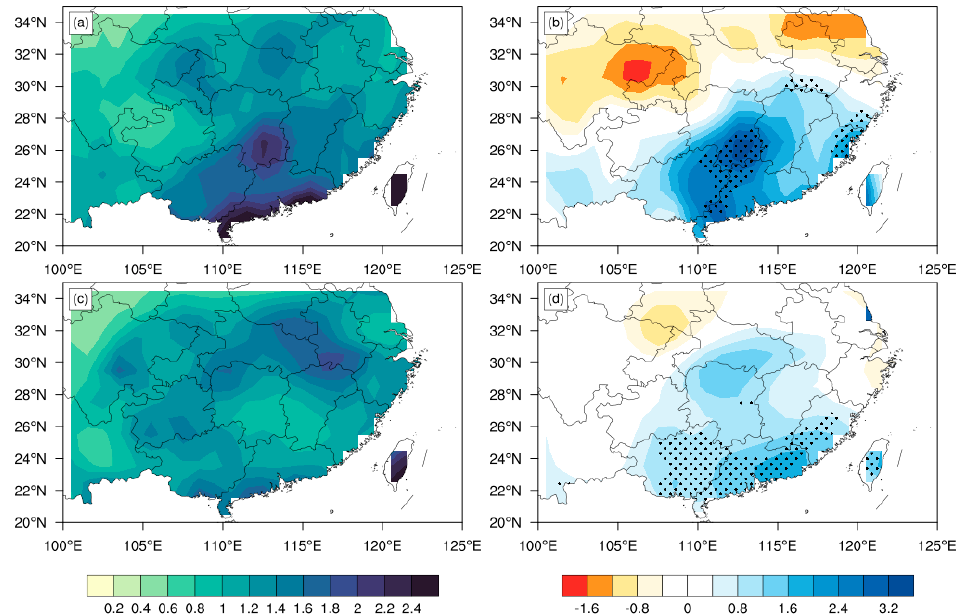
Figure 3. Composite differences in summertime precipitation between wet years and dry years (unit: mm d − 1 ; ( b , d ) for S1 and S2, respectively; dots indicate the regions exceeding 95% confidence level.) and the standard deviation of summertime precipitation (unit: mm d − 1 ; ( a , c ) for S1 and S2).